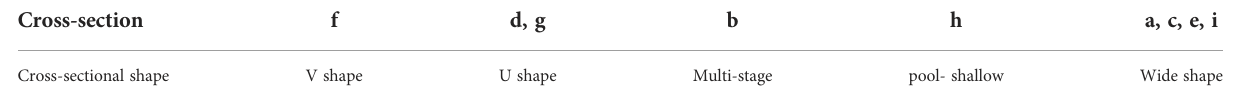
Cross-sectional shape Multi-stage pool- shallow Wide shape a-i directionally represent the downstream to upstream reaches along the study area.